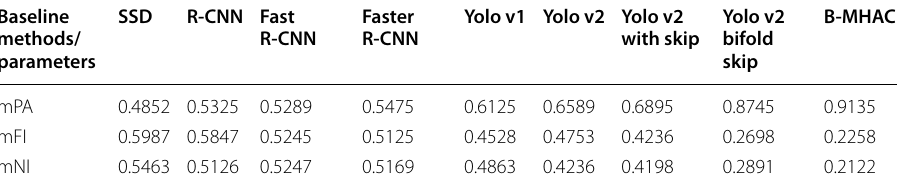
Table 5 Experimental results showing defect identification abilities of TRSE automation models with mAP as the performance indicator